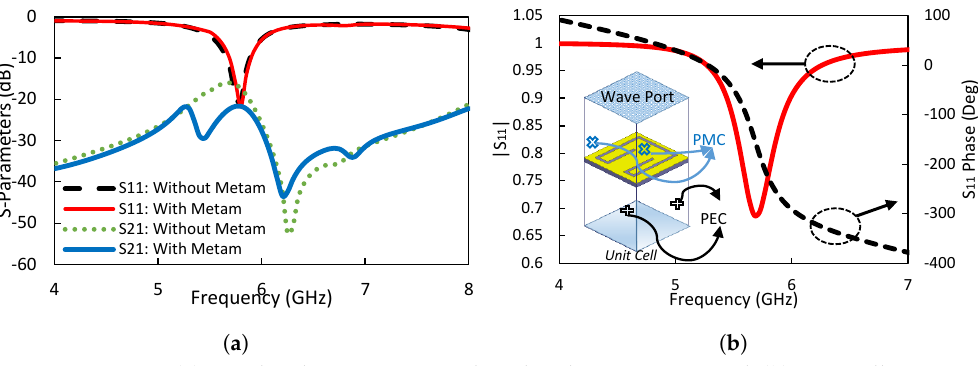
Figure 3. ( a ) Simulated S-parameter with and without metamaterial, ( b ) Unit Cell.